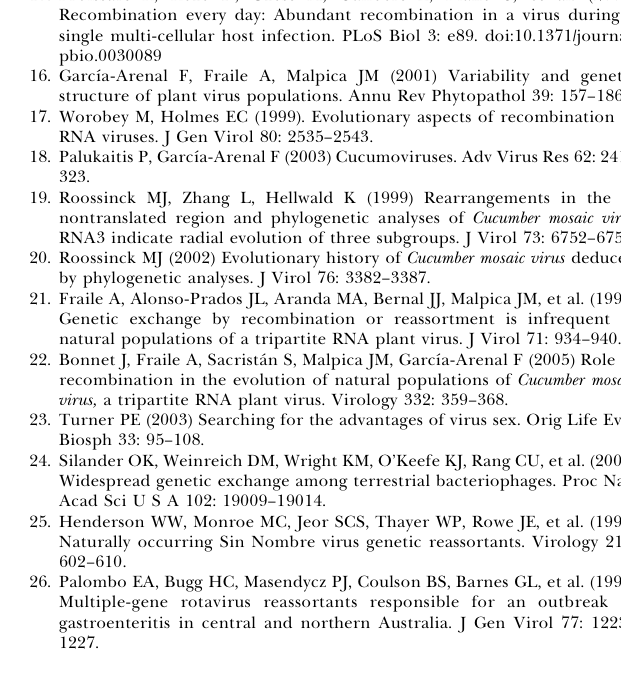
Table S1. Frequency Distribution of Genetic Types in Progenies from Double Inoculations of IA and IB CMV Isolates on the LLH Chenopodium quinoa Data are number of descendants and frequencies referred to the total of the progeny (between brackets). Genotype distributions with the same letter did not differ at a 95% level of confidence. Table S2. Frequency Distribution of Genetic Types in Progenies from Double Inoculations of IA and IB CMV Isolates on the Systemic Host Nicotiana tabacum cv. Xanthi-nc